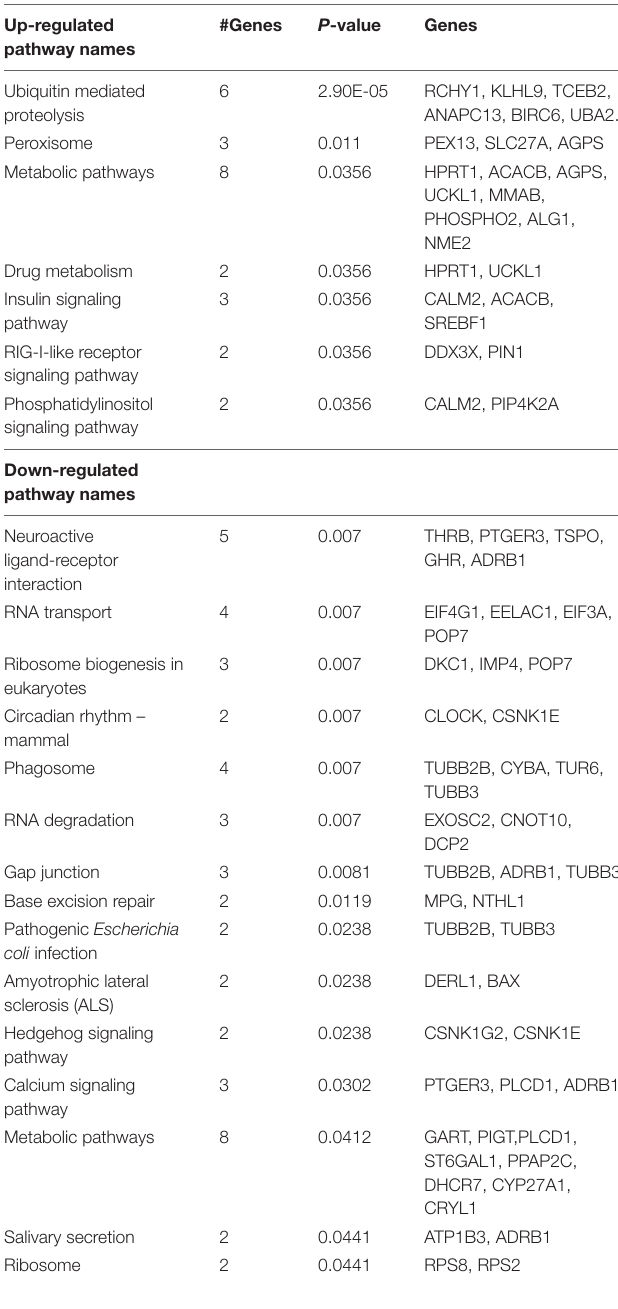
TABLE 1 | KEGG pathways significantly overrepresented in up and down-regulated genes in LV of 2-week-old lambs from cortisol-treated ewes (0.5 mg/kg/day) compared to lambs of control ewes ( n = 8 lambs per group; 4 males and 4